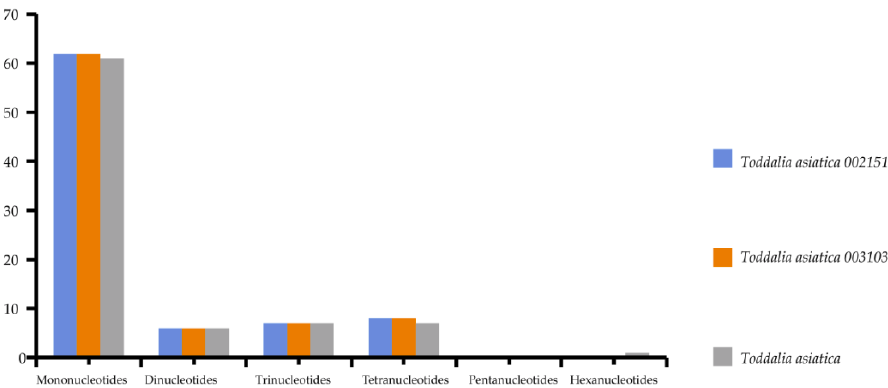
Figure 5. The total number of simple sequence repeats present in Toddalia species.